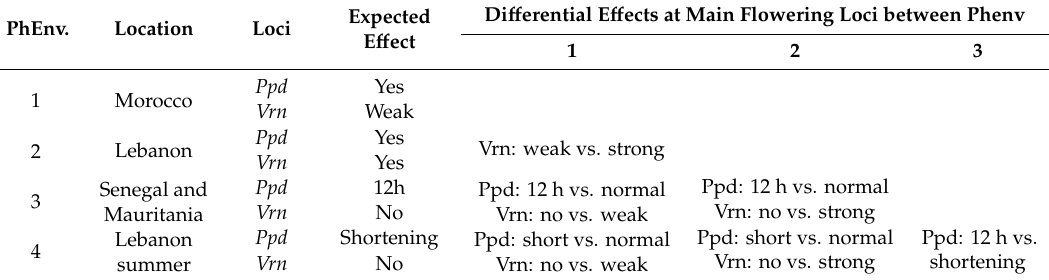
Table1. Matchingofclimaticrequirementsforfloweringbasedonphotoperiodism( Ppd )growingduring the season to over 12 h of daylight, vernalization ( Vrn ) with extended periods of cold temperatures across four phenological environments (PhEnv), and pairing contrasts for their discrimination ability between